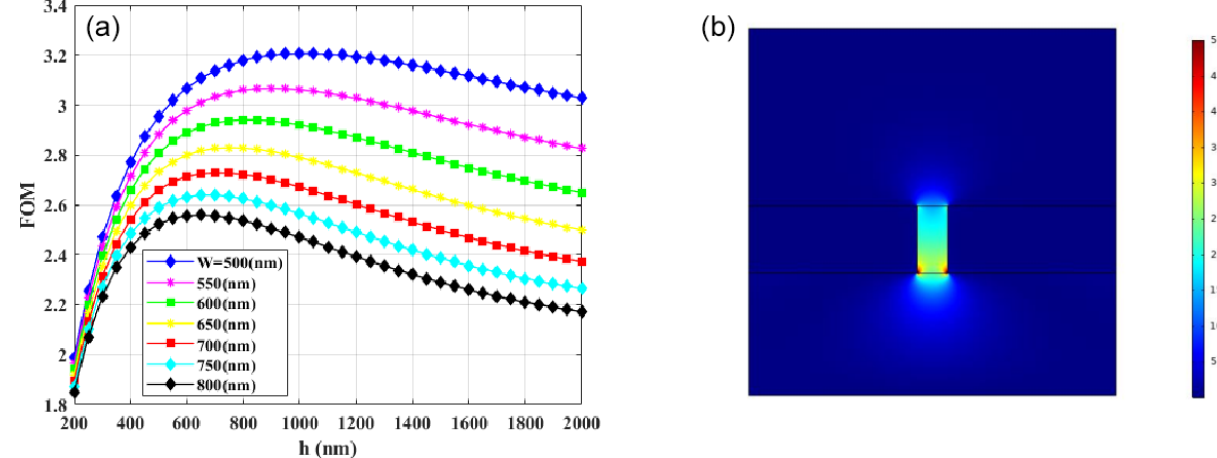
Figure 4. (a) The figures of merit (FOM) as a function of slot height ( h ) for different slot widths ( w ). (b) The x component of the electric field distribution ( E x ) of the SPP mode for optimum values of the